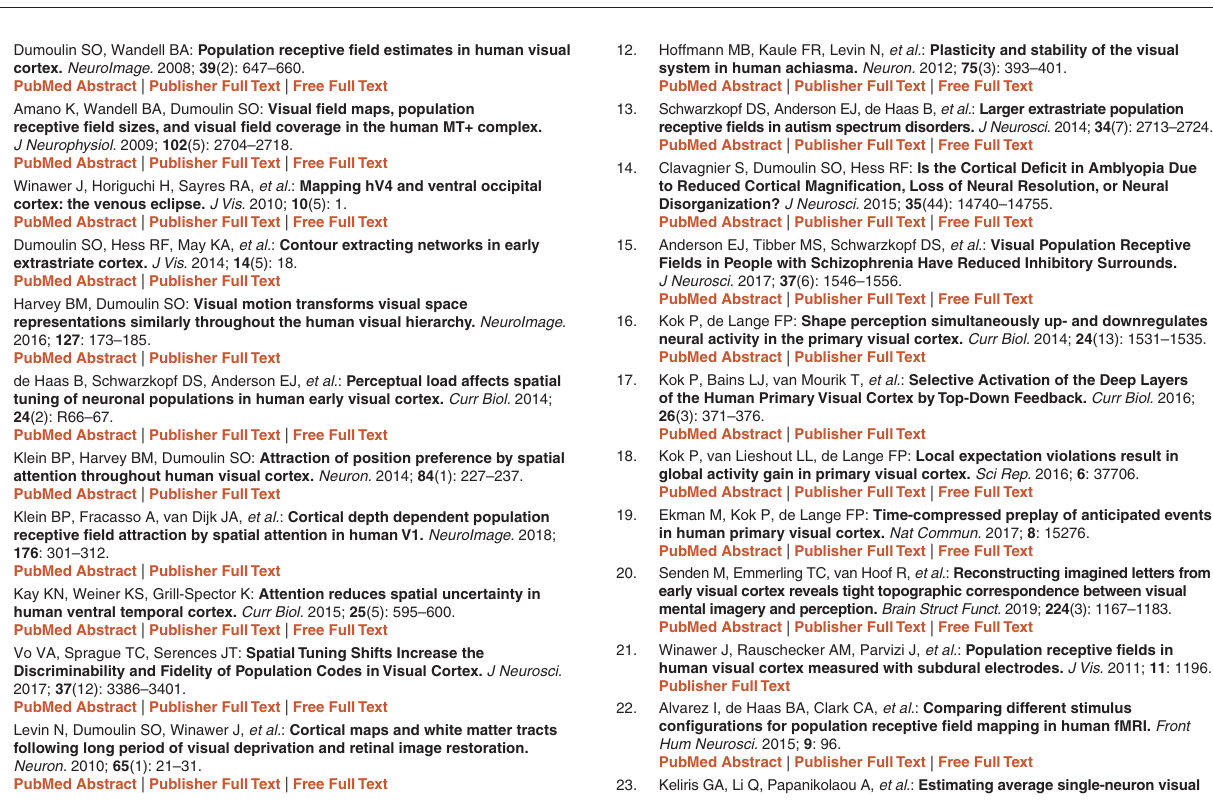
Extended data Supplementary Figure 1. https://osf.io/chtra Mean population receptive field (pRF) size (A), median cortical magnification factor CMF (B) and response amplitude (beta) (C) binned into eccentricity bands for the London 1.5T site (red) and the Auckland 3T site (black). Panels in columns show different visual regions. Panels in rows show the three participants. Error bars denote 95% confidence intervals based on bootstrapping. Supplementary Figure 2. https://osf.io/chtra Median goodness-of-fit (A), normalized goodness-of-fit (B), and noise ceiling (C) binned into eccentricity bands for the London 1.5T site (red) and the Auckland 3T site (black).